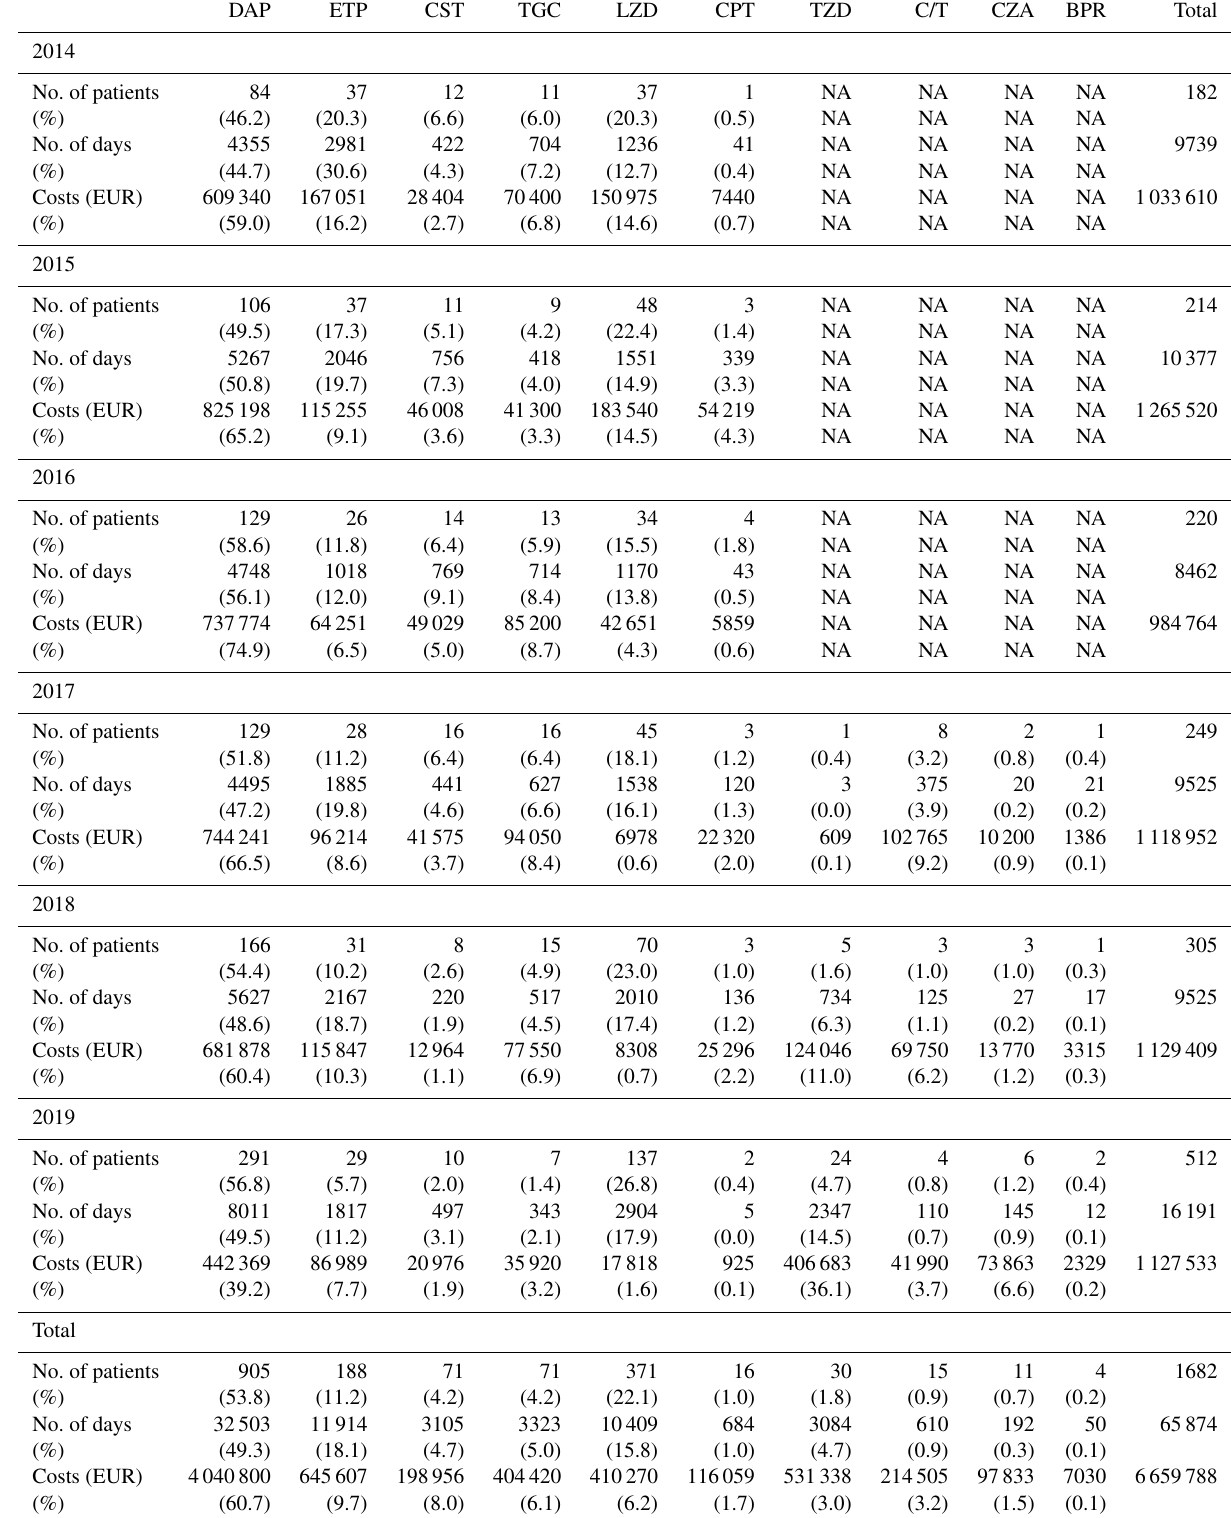
Table 4. Expensive treatments, with the duration and costs by molecule and by year. NA – not applicable; DAP – daptomycin; ETP – ertapenem; CST – colistin; TGC – tigecycline; LZD – linezolid; CPT – ceftaroline; TZD – tedizolid; C/T – ceftolozane-tazobactam; CZA – ceftazidime-avibactam; BPR –